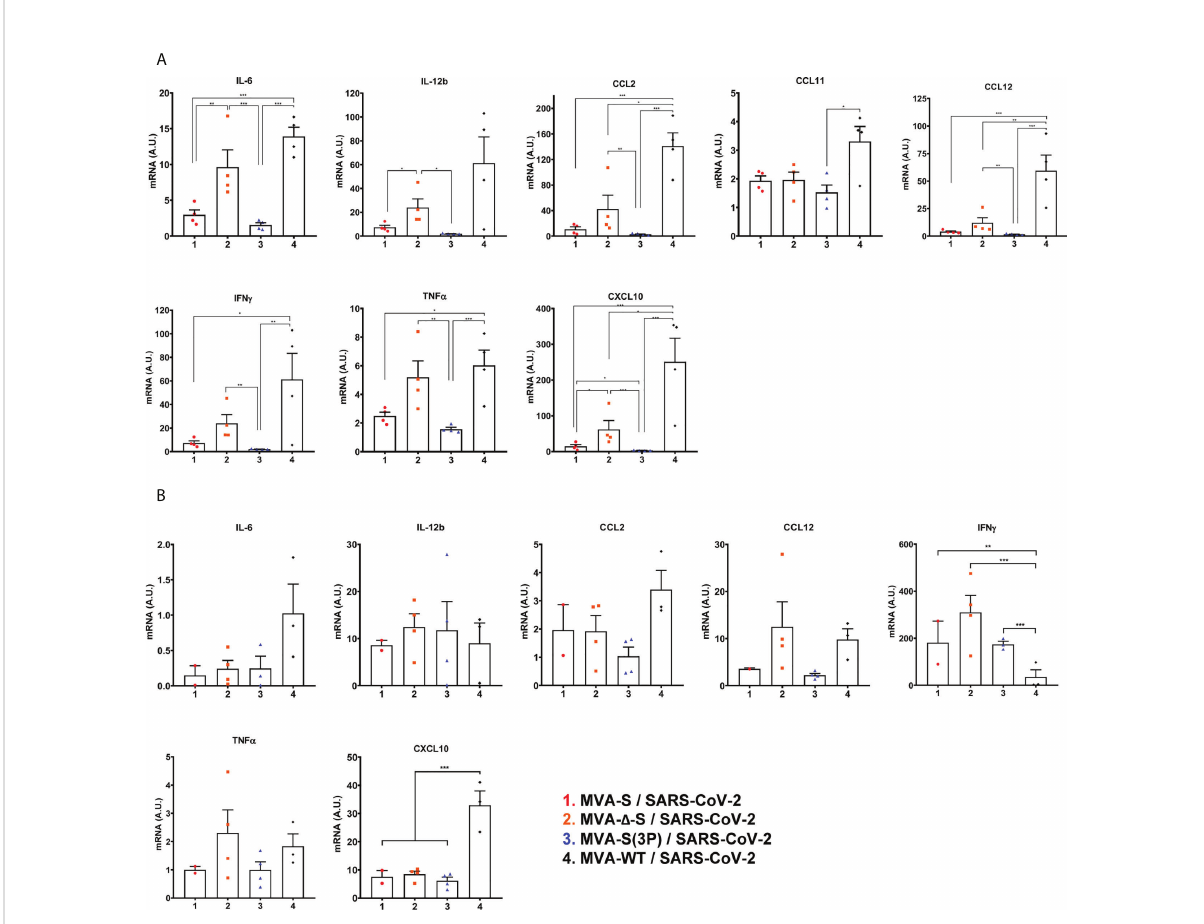
FIGURE 5 One IN dose of MVA-S(3P) diminished levels of pro-in fl ammatory cytokines in K18-hACE2 transgenic mice. mRNA levels of several cytokines/ chemokines were detected by RT-qPCR in lungs (A) and nasal washes (B) obtained at 5 days postchallenge ( n =4/group). Mean RNA levels (in A.U.) and SEM from duplicates of each sample; relative values are referred to uninfected mice. Student ’ s t -test: * p < 0.05; ** p < 0.005; *** p <